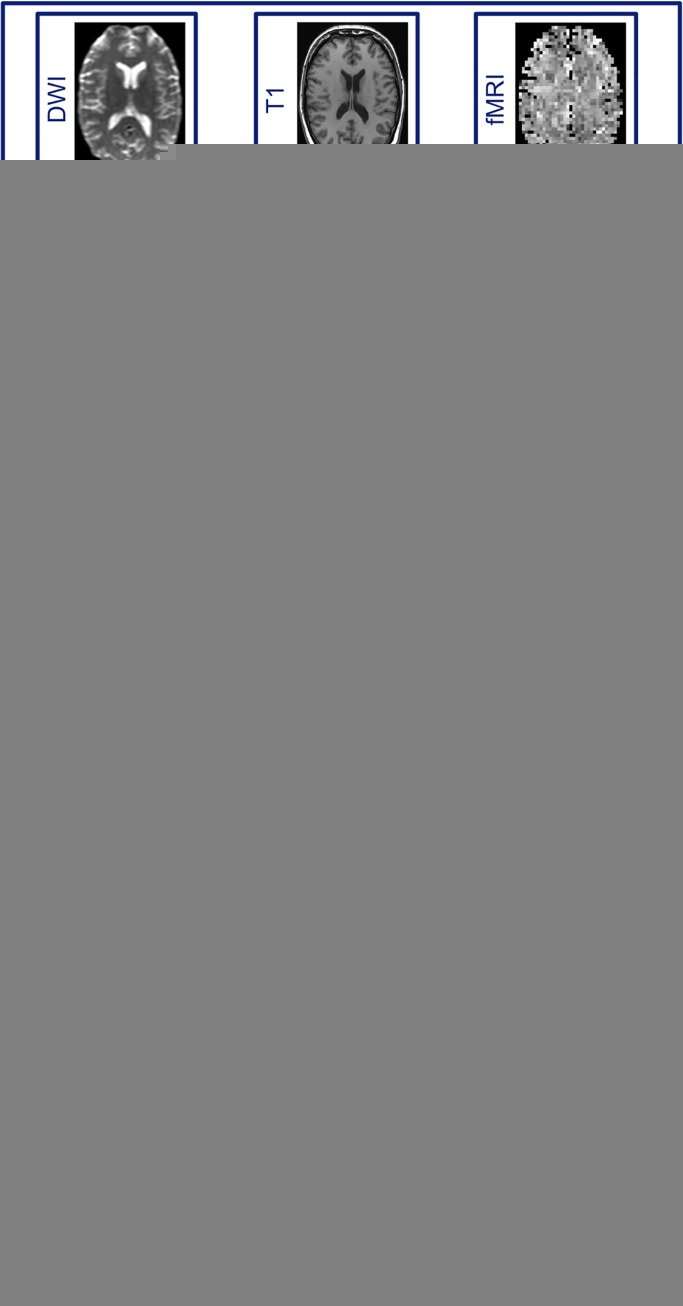
Schematic of method.Networks are extracted for each individual (upper panel) by extracting brain regions from the T1 image using FreeSurfer, and extracting structural and functional connectivity between these regions from preprocessed DWI and fMRI, respectively. Subsequently, integrated analysis of group differences in structural and functional connectivity is performed (lower panel). Group differences are visualized on a global level using bi-modal distribution plots, on an individual connection level using connectograms and on a mid-level using worm plots, where connections are grouped by location in the brain.